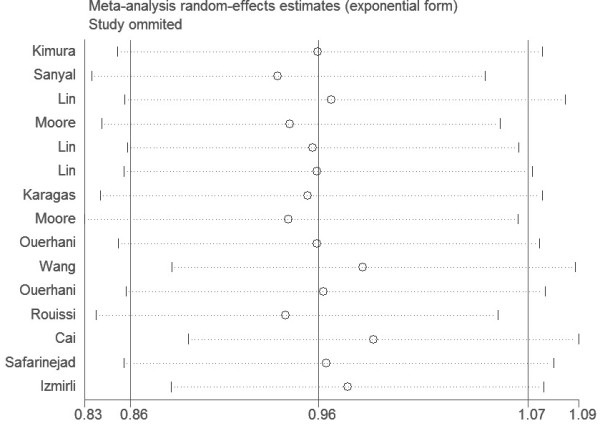
Sensitive analysis for the MFHTR Ala222Val polymorphism illustrating the influence of each studies on pooled OR (Ala- allele vs Val allele).